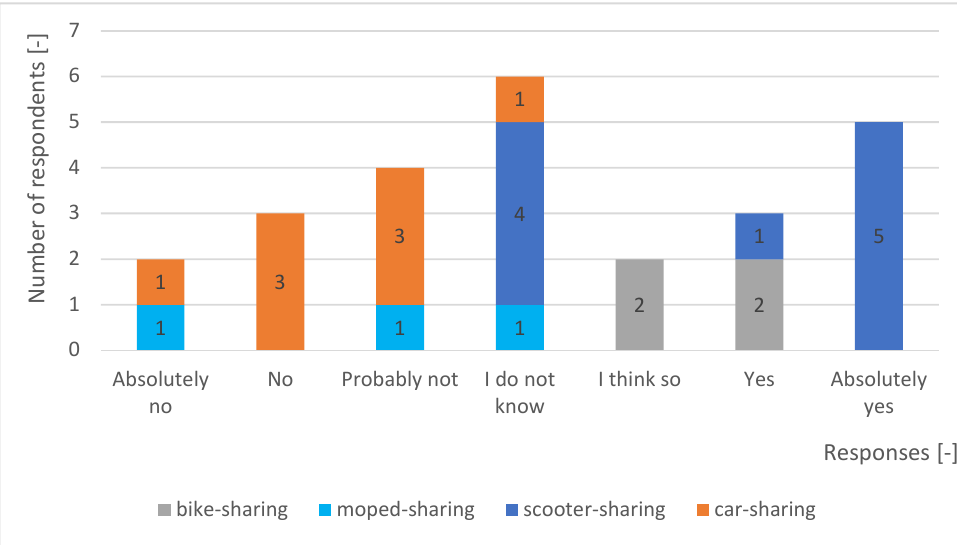
Figure 4. Interest in connection to Mobility as a Service system.